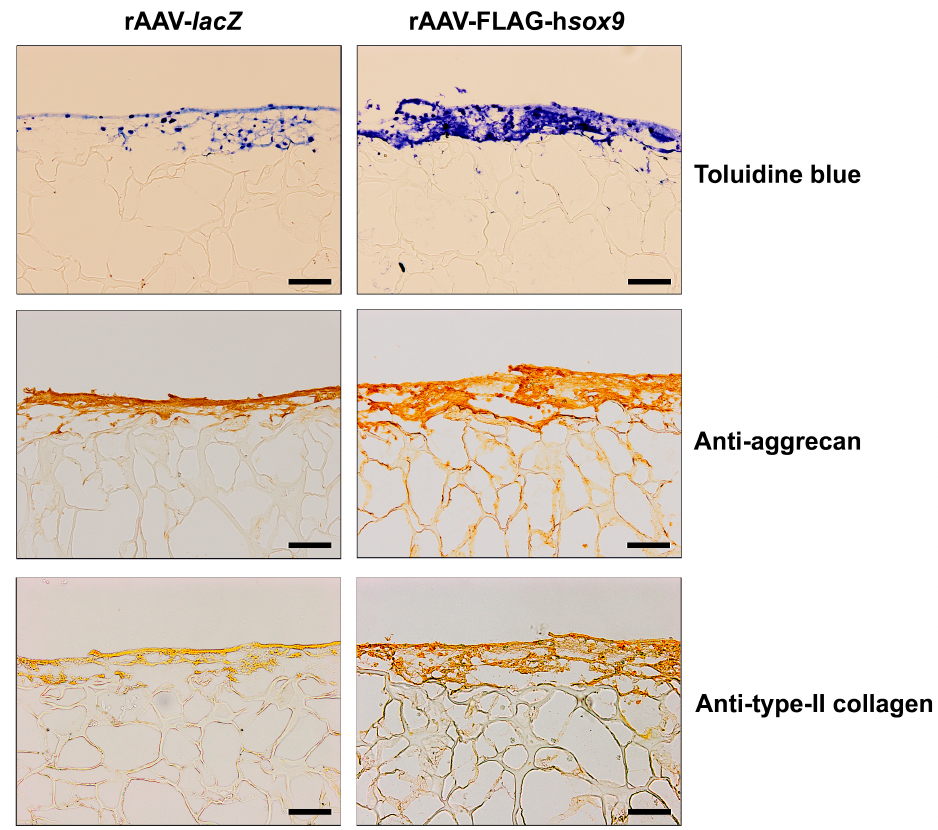
Figure 3. Histological analysis in hydrodynamic cultures of rAAV-transduced hMSCs seeded in fibrin-PU scaffolds. Cells were transduced, seeded in PU scaffolds, and placed in rotating bioreactors as described in Figures 1 and 2 and in Materials and Methods. The samples were processed after 21 days for histological staining with toluidine blue and to detect immunoreactivity to aggrecan and to type-II collagen (magnification ×10; scale bar: 200 µm; all representative data). Similar to the immunoreactivity to SOX9, the high signals at the surface of the constructs can be attributed to a diffusion gradient of the nutrients into the center of the constructs at homogenous cell seeding.